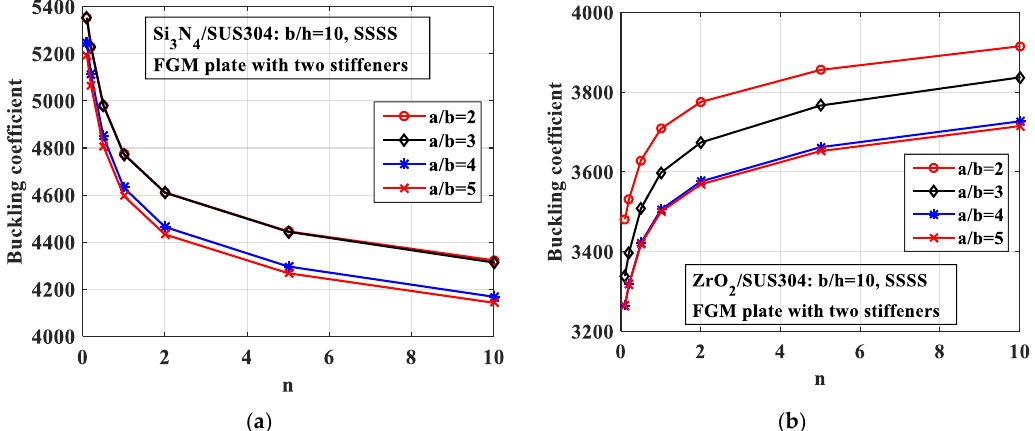
Figure 17. Variation of the buckling coefficient of the plate with two parallel stiffeners by changing of a / b ratio. ( a ) Si 3 N 4 /SUS304; ( b ) ZrO 2 /SUS304.